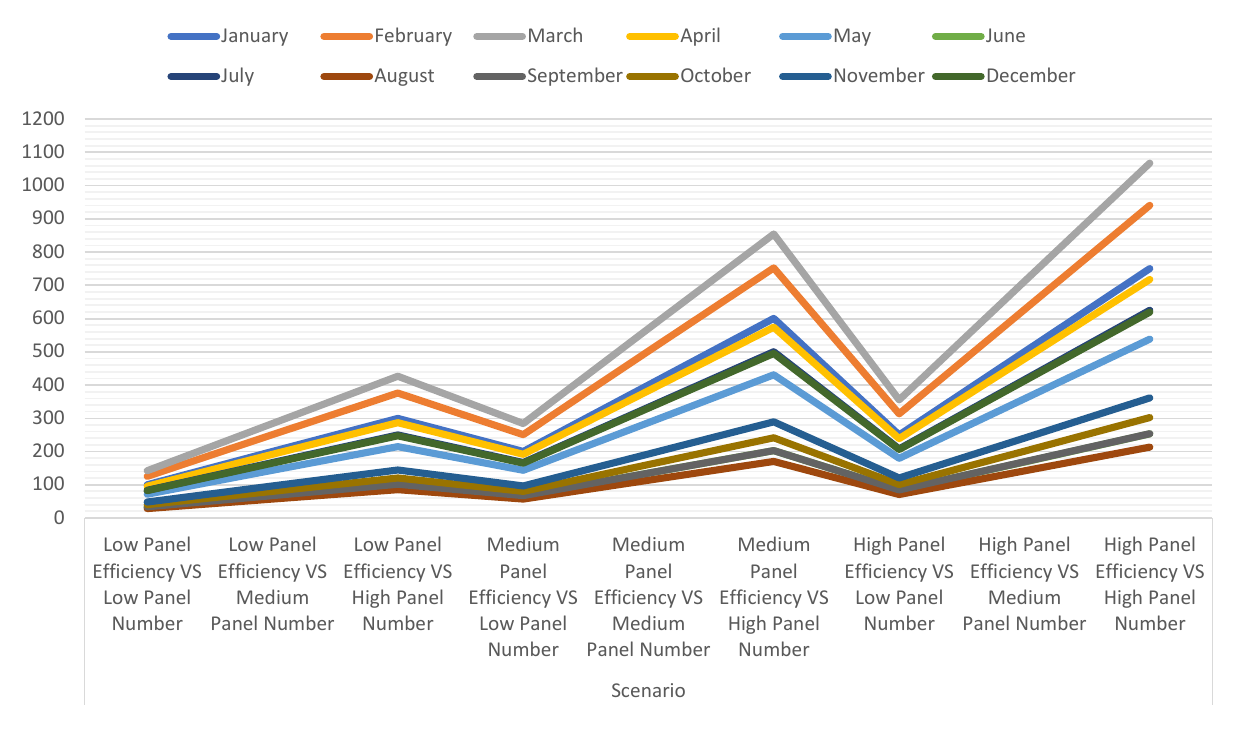
Figure 13. Generated to Consumed Electrical Energy Ration (GtoC)% .